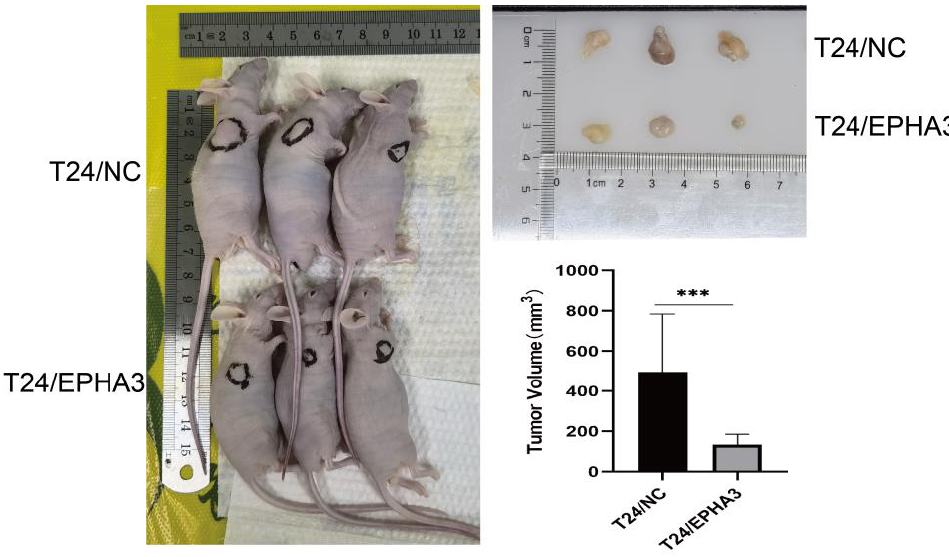
Figure 11. EPHA3 hindered in vivo tumor development. The xenograft tumor volume was measured and recorded. *** p < 0.001.